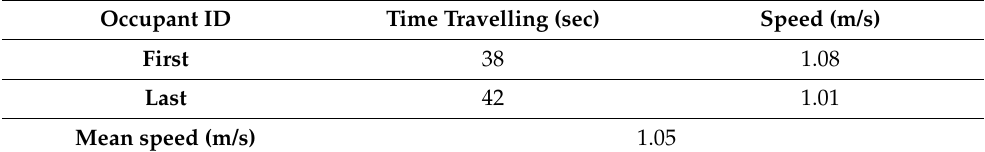
Table 5. Occupants’ speed (m/s) in drill no.2 (smoke-filled environment).